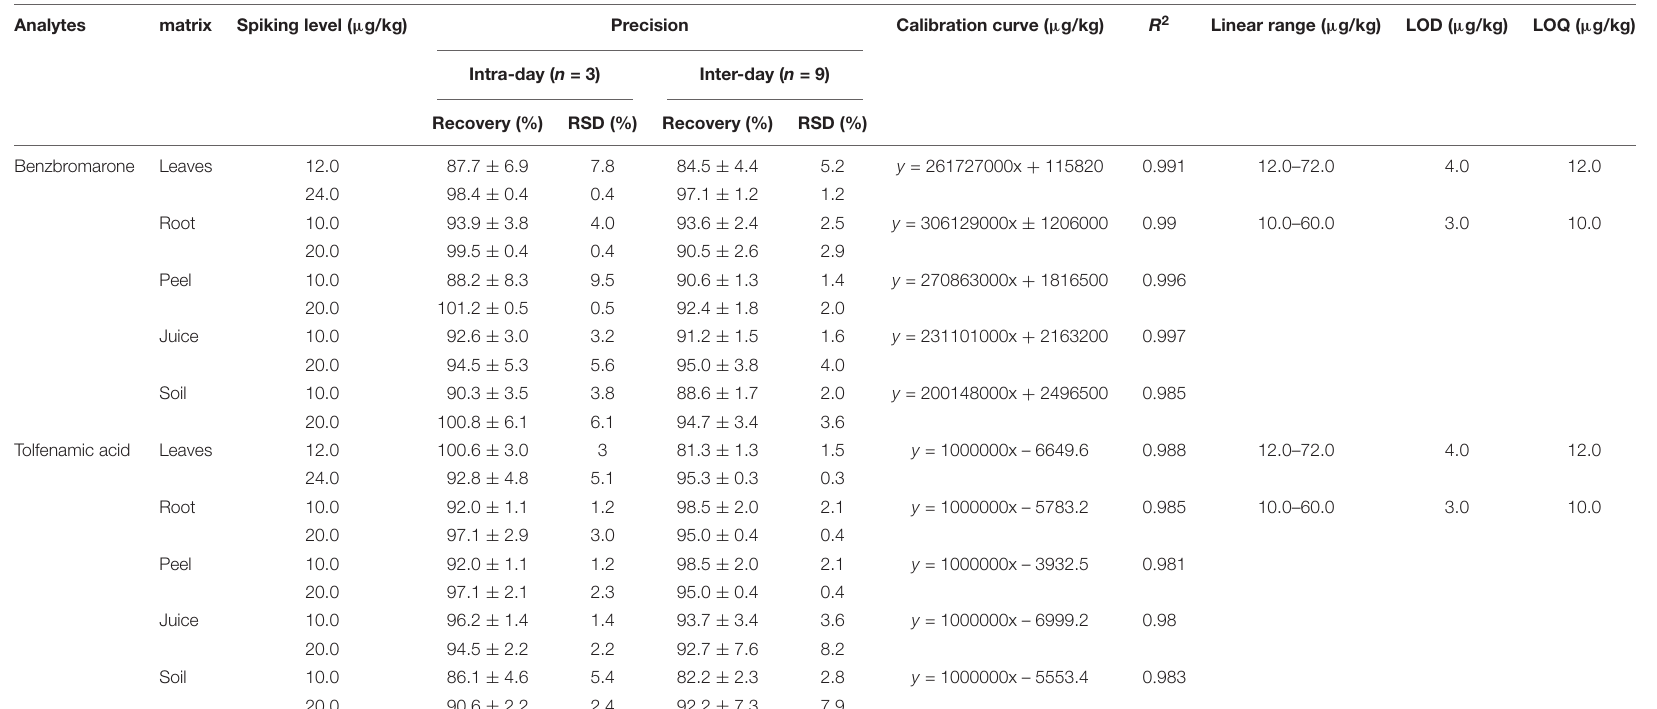
TABLE 3 | Performance parameters of benzbromarone and tolfenamic acid in different matrices.